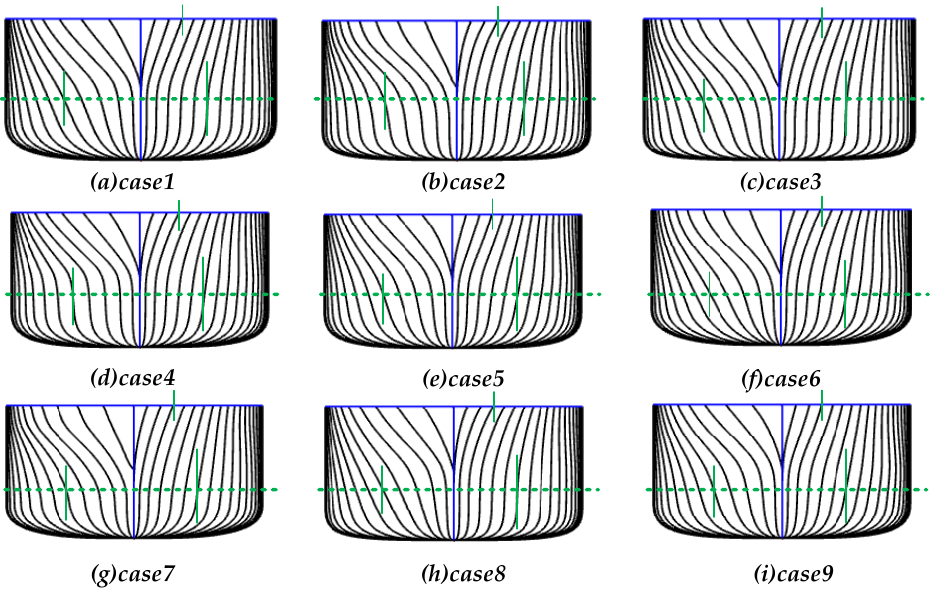
Figure 20. Cross-section view of the hull for each case. Table 5. The hydrostatic data corresponding to each